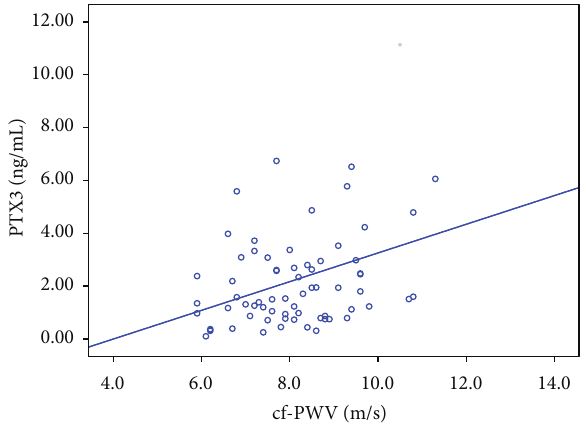
Figure 2: Correlation between pentraxin 3 and cf-PWV (arterial stiffness) in the study population ( 𝑟 = 0.359 ; 𝑃 = 0.003